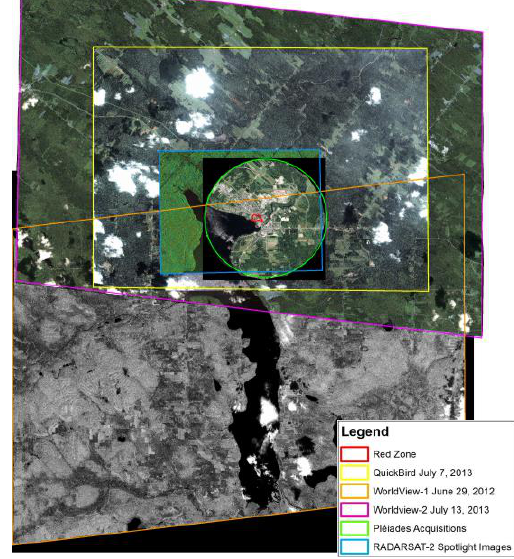
Figure 2. The Footprints of Satellite Images listed in Table 1, acquired for Project use for the Lac-Mégantic Disaster area.